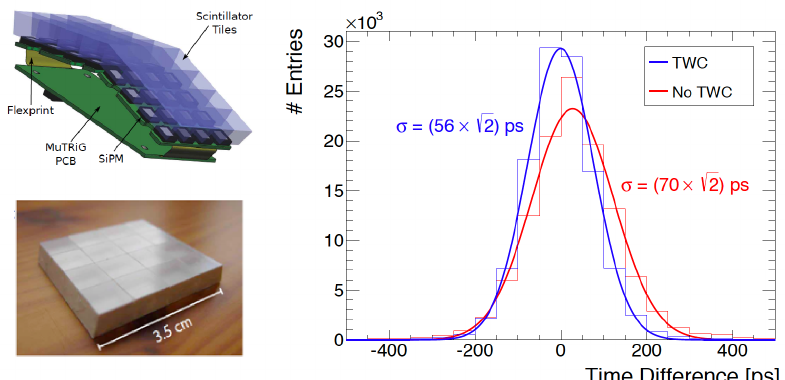
Figure 10: Overview of the scintillating tile detector in the recurling stations of the Mu3e apparatus: design of the detector (top left), the scintillating tile matrix (bottom left), and achieved time resolution